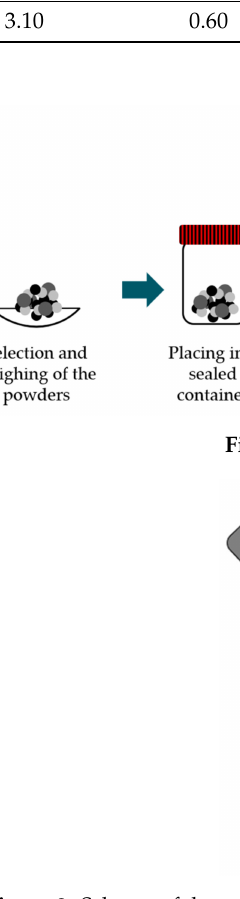
Figure 2. Scheme of the mold cavity with the inserted green compacts and the reinforced cast